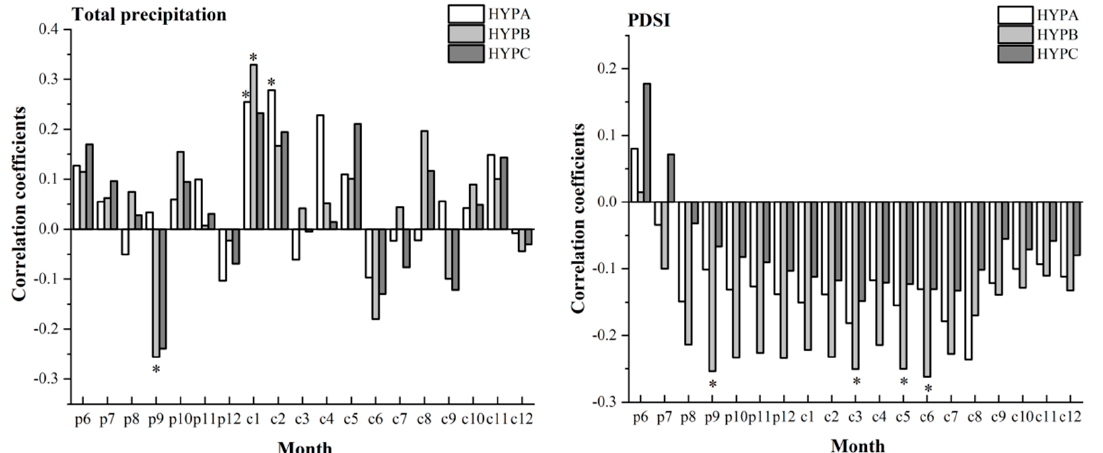
Figure 8. Correlations between the L. principis-rupprechtii tree-ring chronologies and the monthly precipitation and between the chronologies and the PDSI values ( p represents the previous year; c represents the current year; and the * symbol represents a significant correlation at the 0.05 level).